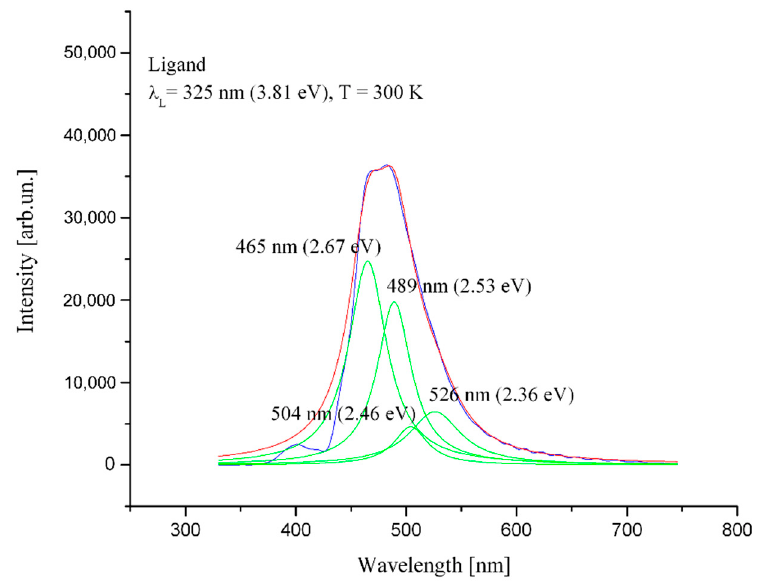
Figure 8. Photoluminescence characteristics of the chloride ligand salt. Blue, curve of the experimental intensity; red, curve of the fitted total intensity; green, curve of the fitted individual peaks .